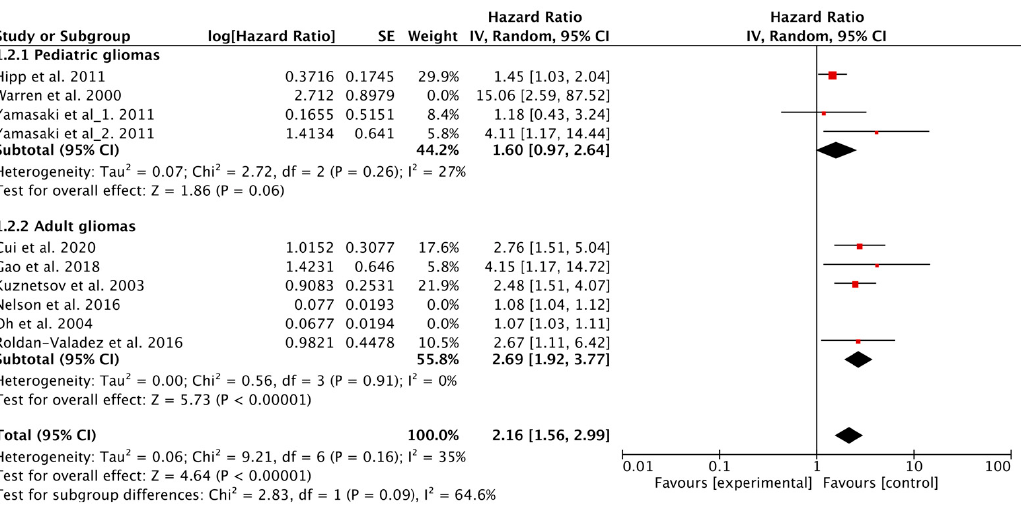
Figure 3. Forest plots of the subgroup analysis of OS in the selected studies using choline as param- eters.